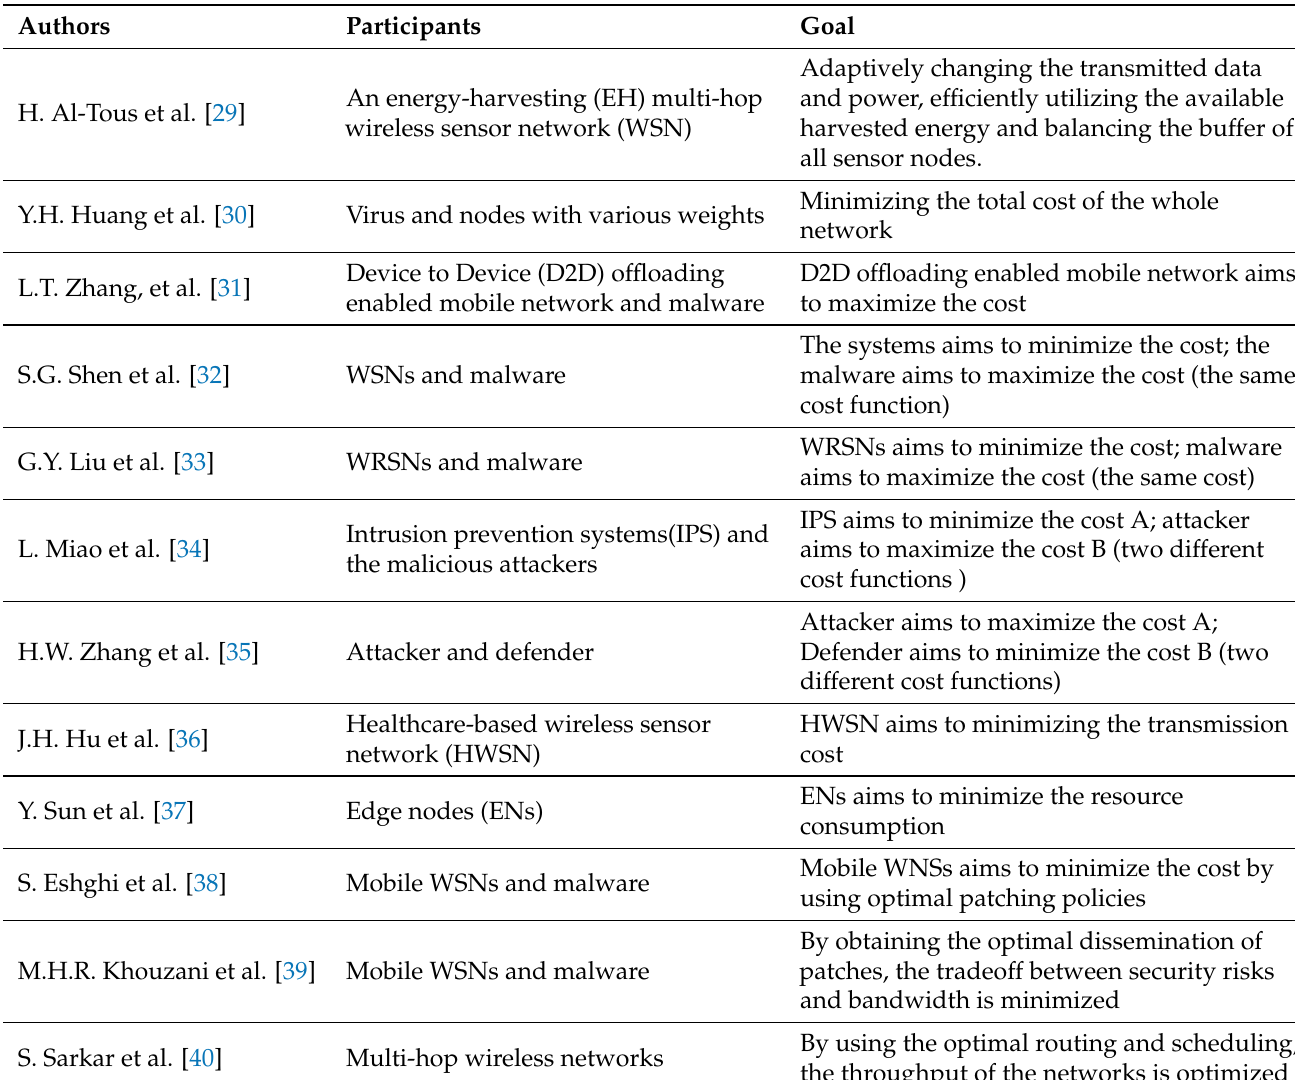
Table 2. Researches on differential game applied in